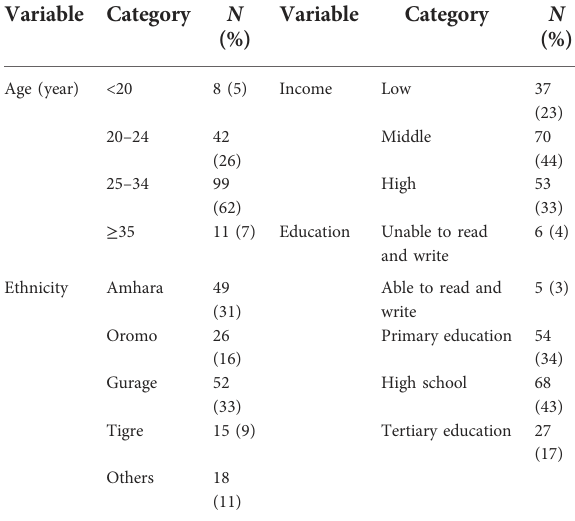
TABLE 1 Socio-demographic characteristics among pregnant women with preterm premature rupture of